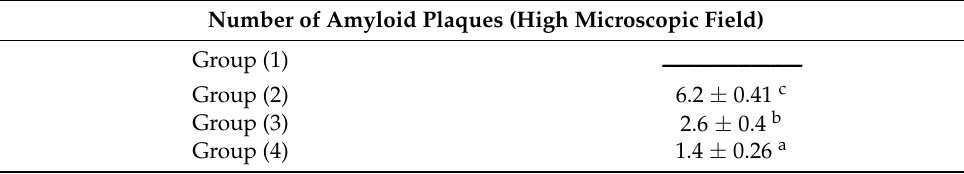
Table 5. The number of amyloid plaques recorded in the brain of the